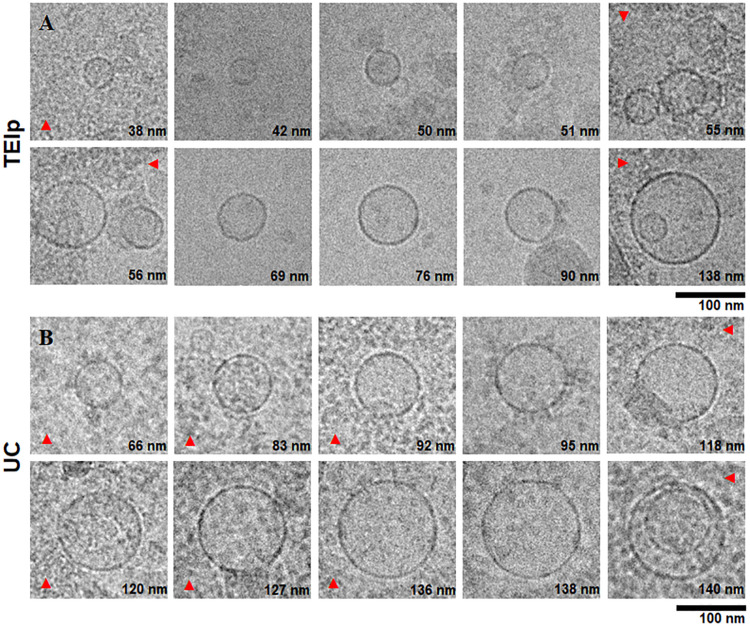
Characterization of small extracellular vesicles by cryo-electron microscopy. Gallery of digital micrographs showing small EVs and lipoprotein contamination (red arrows) in samples isolated from LC patients plasma by exosome isolation TEIp kit (A) (top panel) and UC (B) (bottom panel).